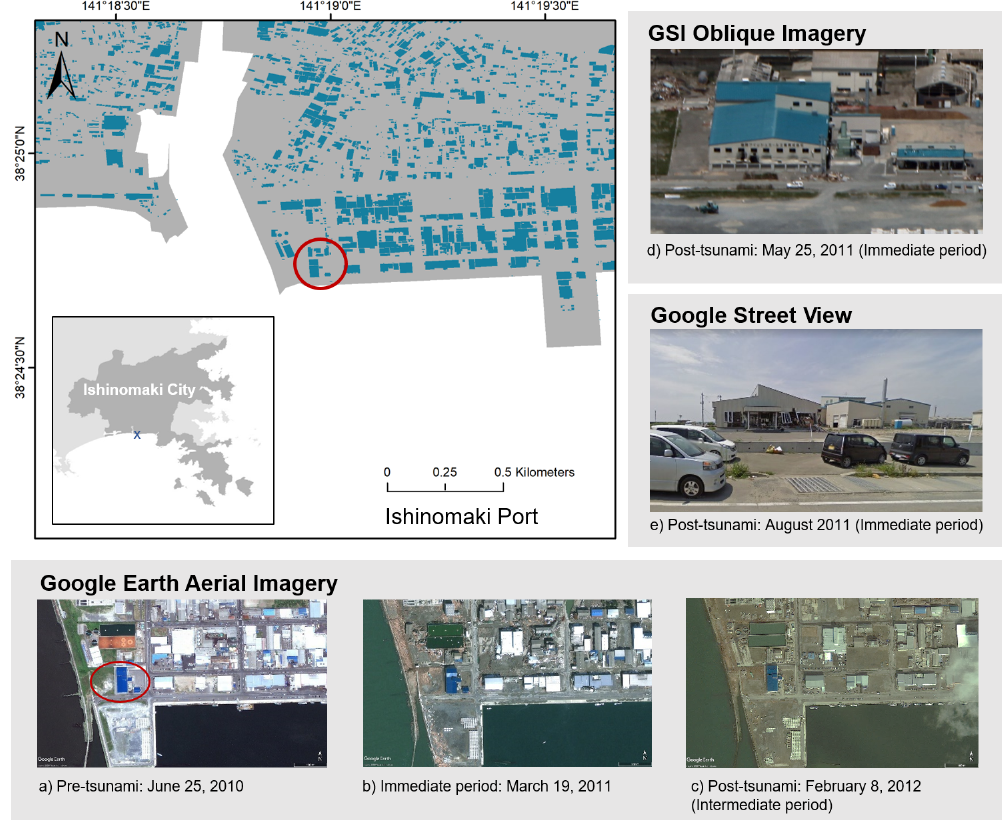
Figure 4. A building (circled in red) in Ishinomaki Port has been selected to demonstrate how spatio-temporal damage assessment had been conducted in this study. For every port structure, we reviewed four main sources of data (© Google Earth 2020, © Google Street View 2020, GSI aerial and oblique images) to estimate the level of damage sustained during the tsunami.